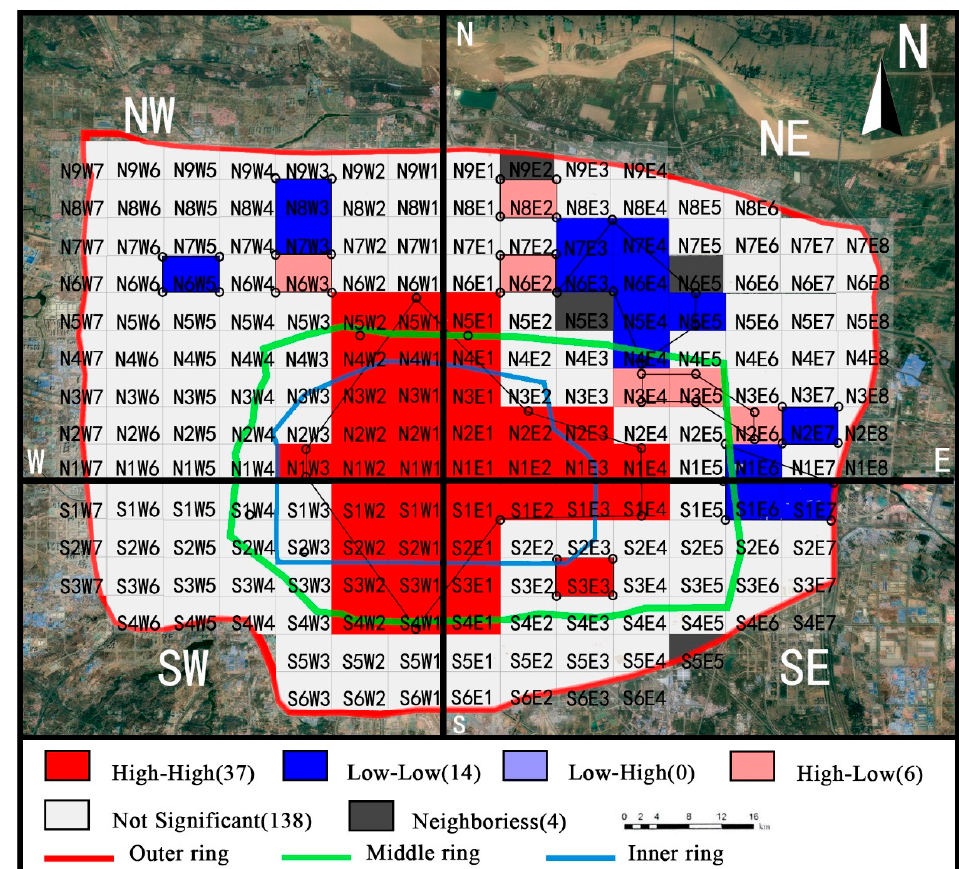
Figure 8. 3D spatial local auto-correlation of architectural form in the study area.